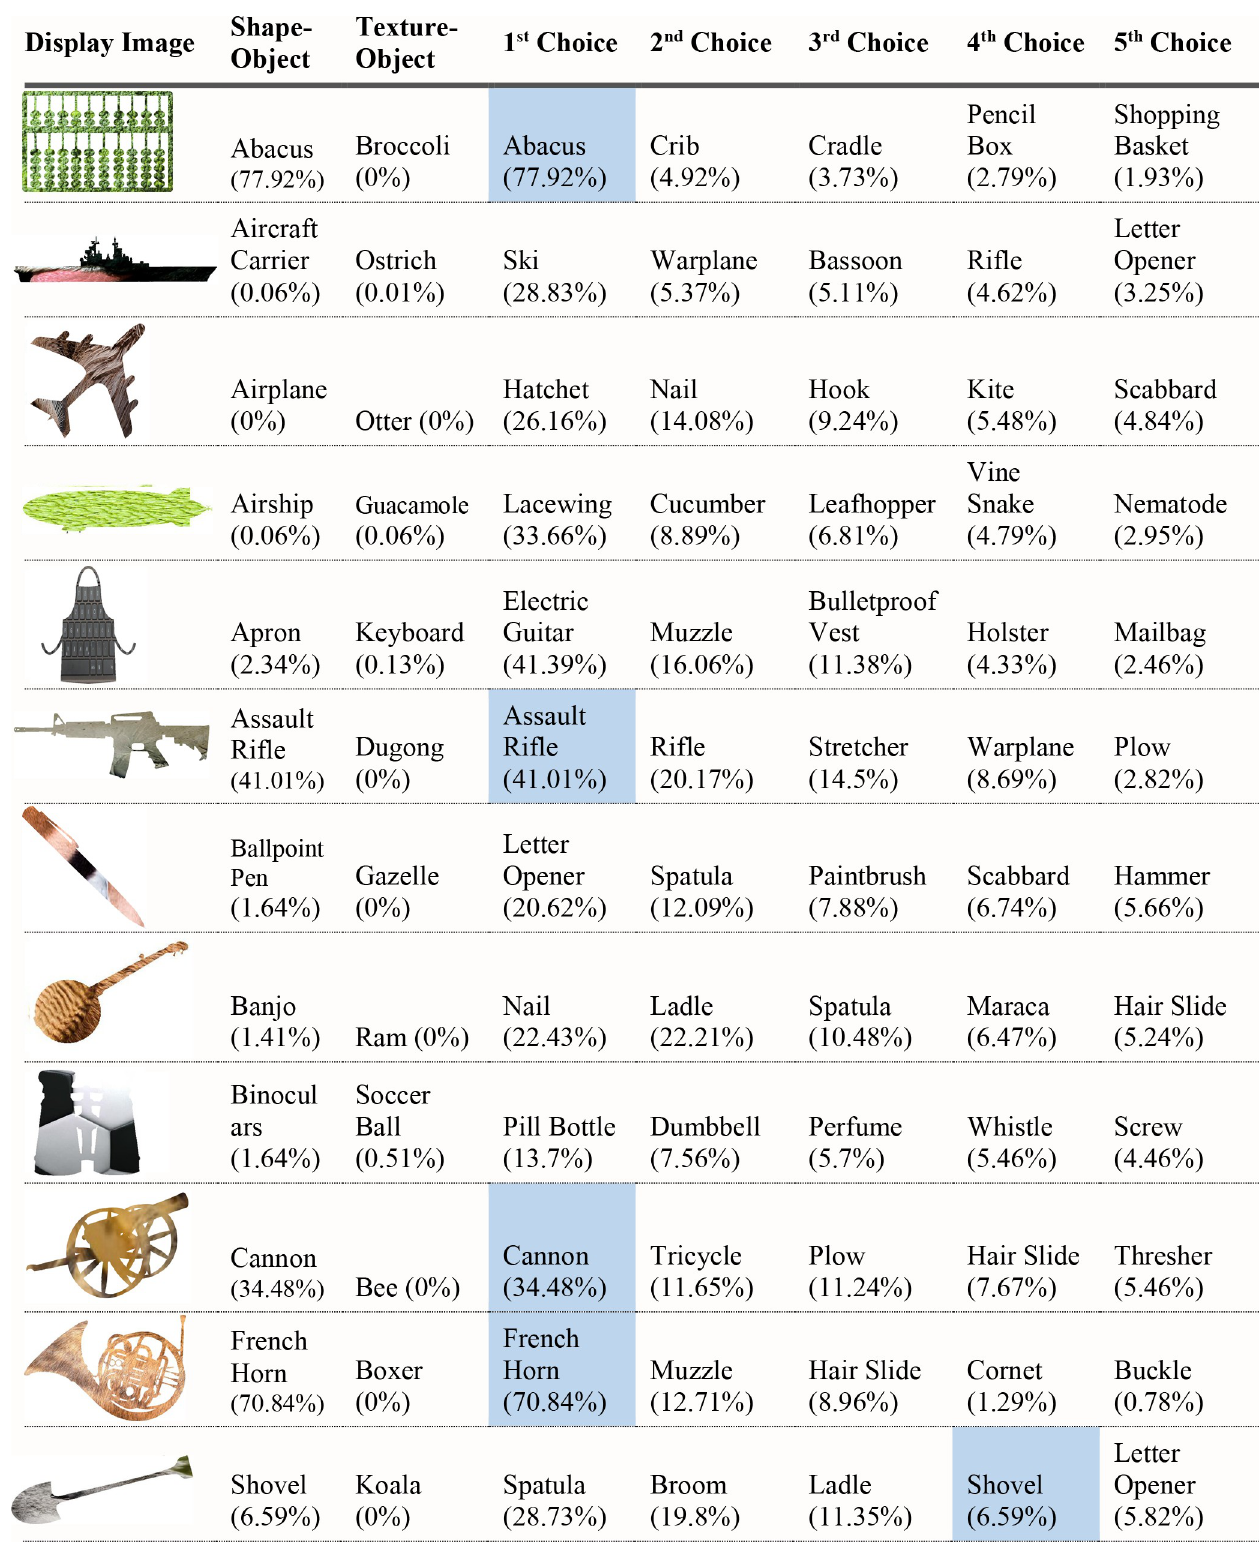
Fig 5. Network classifications for the stimuli presented in Experiment 1 Part 3.